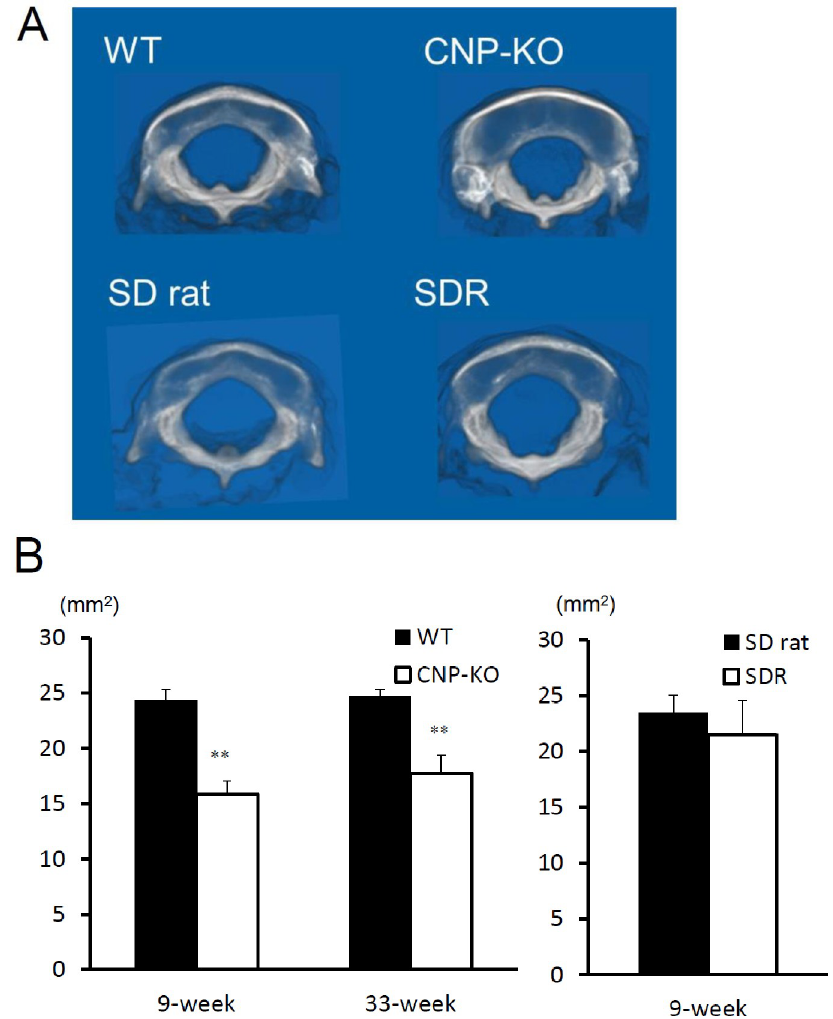
Fig 3. Foramen magnum size in WT, CNP-KO, SD, and SDR rats. (A) 3D-reconstructed images of the foramen magnum in WT and CNP-KO rats at 9 weeks of age, and in SD rats and SDRs at 9 weeks of age. (B) Foramen magnum size in WT and CNP-KO rats at 9 and 33 weeks of age (N = 3 each), and in SD rats and SDRs at 9 weeks of age (N = 5 each). Data are expressed as the means ± SD. � , P < 0.05, �� , P < 0.01 vs. WT or SD rats using Student’s t -test.